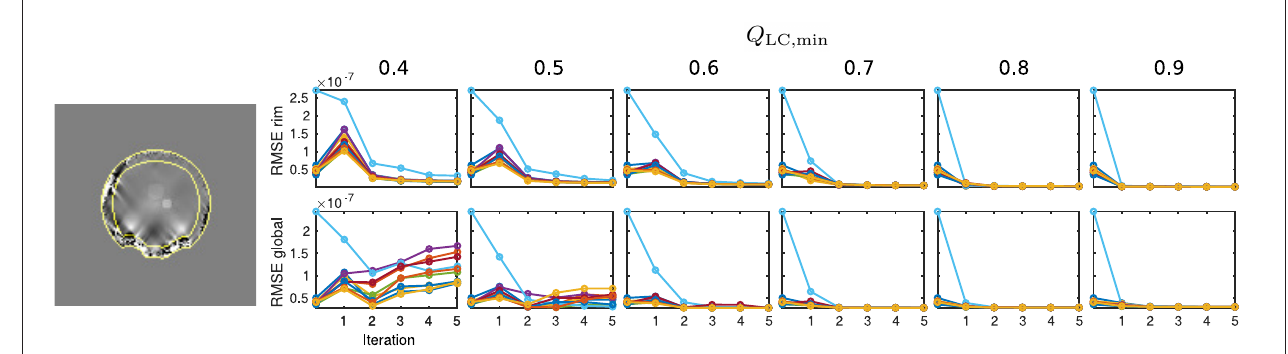
FIGURE 8 | Results of the RMSE analysis on numeric data. On the left-hand side, the rim region delineation is visualised on a coronal sample slice from the numeric data (first iteration, Q LC,min = 0.7), indicated by yellow lines. On the right-hand side, the results for global and rim RMSE are plotted for each computed value of Q LC,min and each iteration. Conventional calculation without REFRASE is shown as the 0 th point. One individual colour is used for each Monte Carlo case.